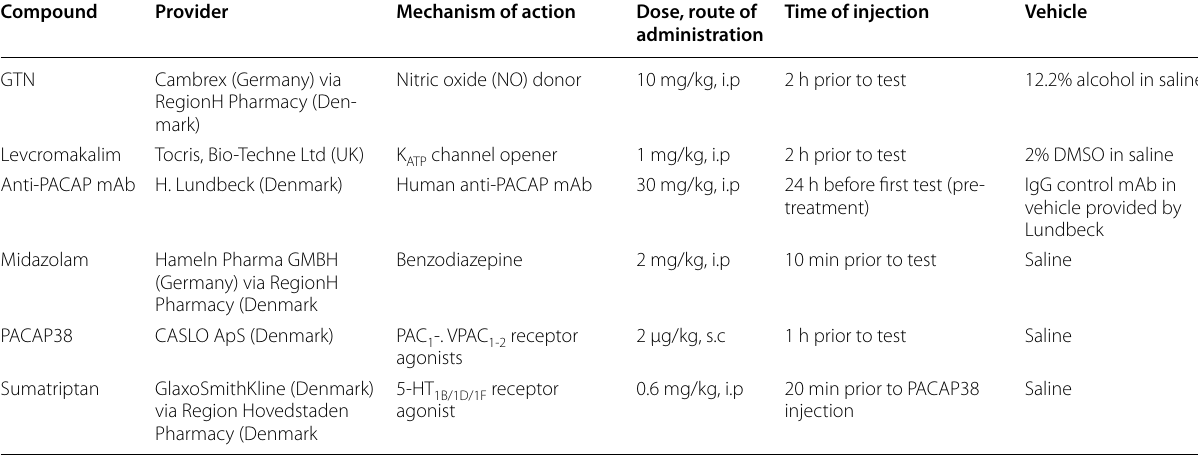
Table 2 Overview of study compounds used in vivo (alphabetical order)